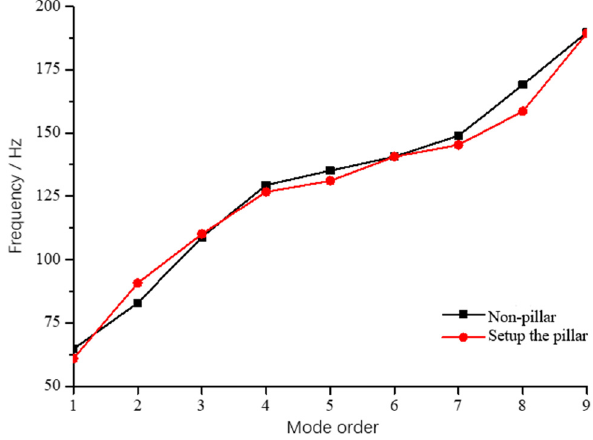
Figure 7: Variation of natural frequency of C cabin